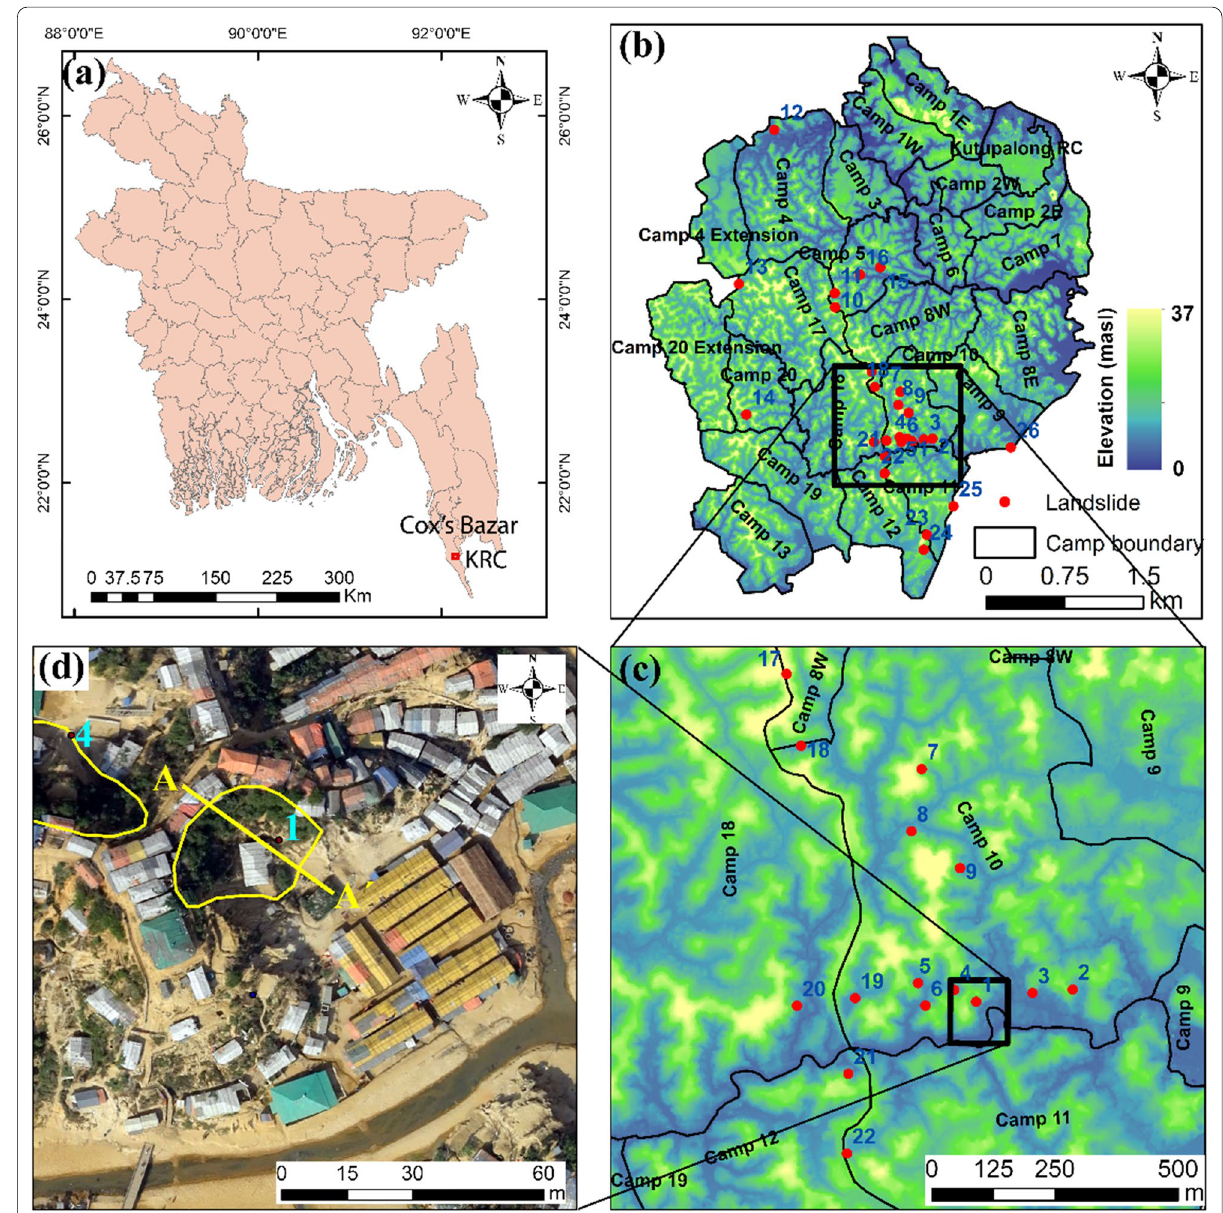
Fig. 1 Location of the landslide occurrence area: a location of the Kutupalong Rohingya camps (KRC) on the administrative map of Bangladesh; b field-collected landslide inventory on the elevation map (0.5 m 0.5 m) of the KRC; c enlarged view of the worst landslide affected camp 10 and × the adjacent area; and d reported landslide extent on a pre-disaster drone image of 0.1 m resolution. Image Source